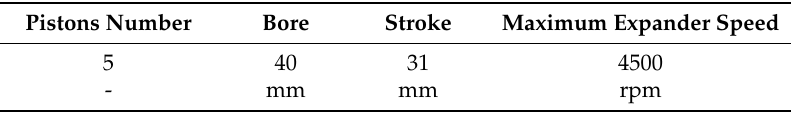
Table 3. Swash-plate characteristics.